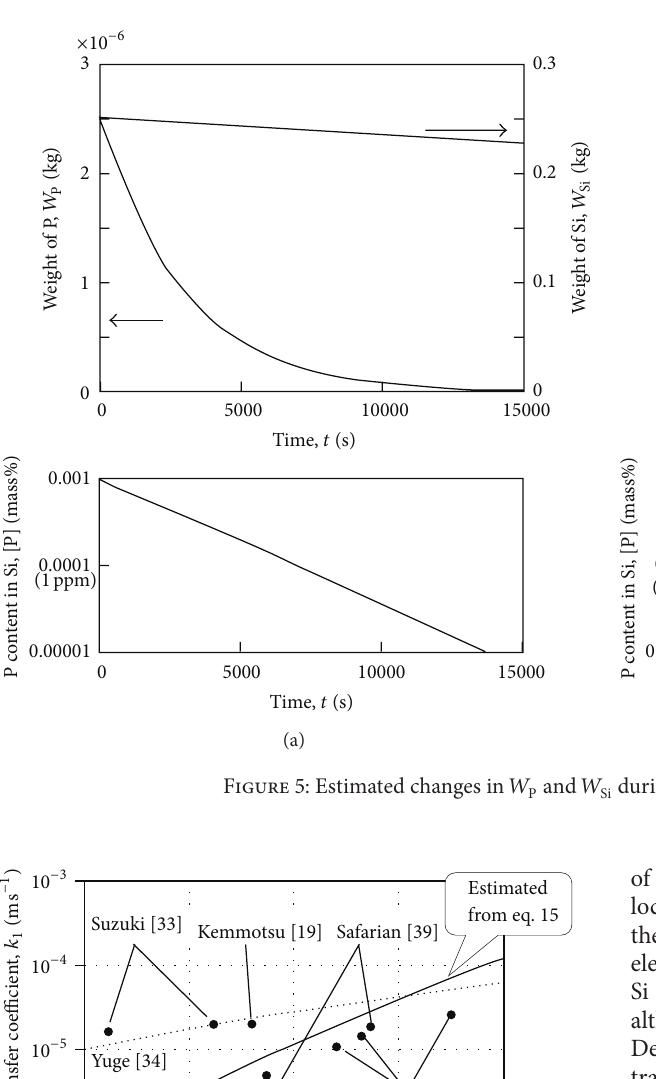
Figure 6: Apparent mass transfer coefficient of P removal from molten